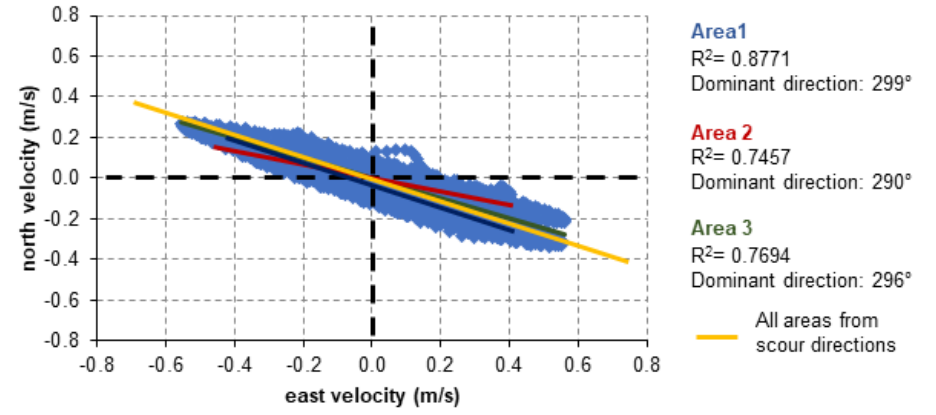
Figure 14. Near seabed velocities showing the directionality of current for Area 3. Trends for Areas 1 (blue) and 2 (red), as well as the summary trend (yellow) for all the observed data (scours) are also plotted. Note the dominant direction indicated is towards the bearing value indicated.